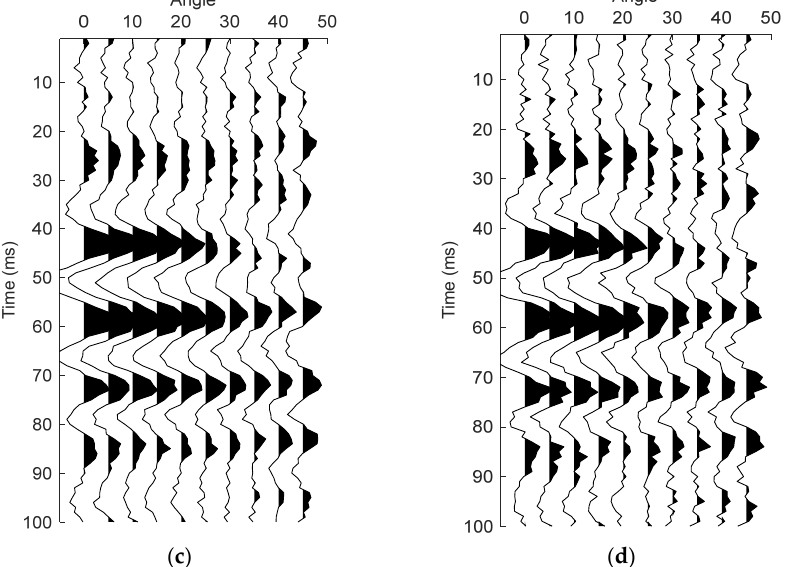
Figure 12. Synthetic PP seismograms computed with the exact reflection coefficient of VTI media with different SNRs by adding white Gaussian noises. ( a ) Noise free, ( b ) SNR = 10, ( c ) SNR = 5, and ( d ) SNR = 3.